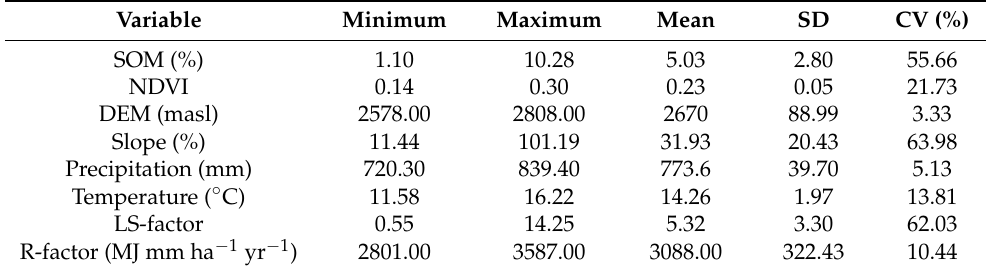
Table 4. Descriptive statistics of SOM and environmental variable at the sampling